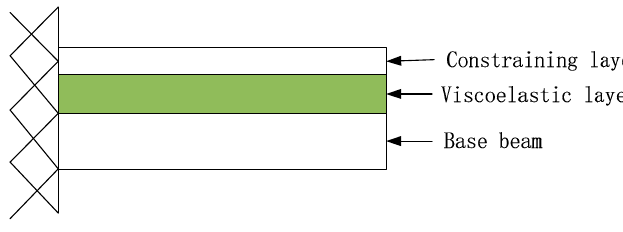
Figure 1. Viscoelastic composite beam structure.